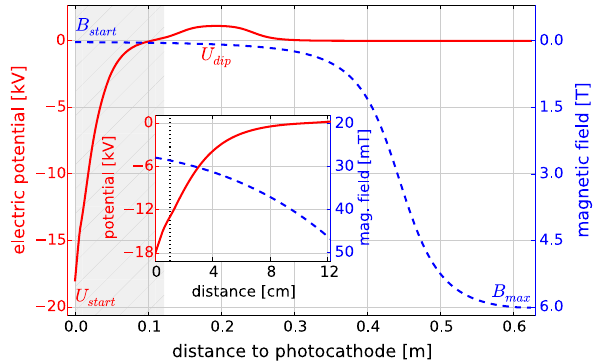
Fig. 11 Simulated electric potential ( solid red, left axis ) and magnetic field ( dashed blue, right axis ) at the monitor spectrometer setup w.r.t. tothepositionofthephotocathode. Theelectronsareemittedat U start = − 18 . 6kV and accelerated towards ground potential. Trapped electrons areremovedbyadipoleelectrodewith U dip = + 2kV.Thespectrometer magnetwith B max = 6Tincombinationwithanadditionalaircoilatthe electron source also defines the initial magnetic field B + start = 27mT. Thelengthofthesourcecagecorrespondstothe shadedregion ,whichis enlarged inthe inset . An accelerationpotential U acc = + 5kV is applied at the front plate (indicated by a dotted line in the inset ) Fig. 12 Simulated energy distributions of 1000 electrons at U start =